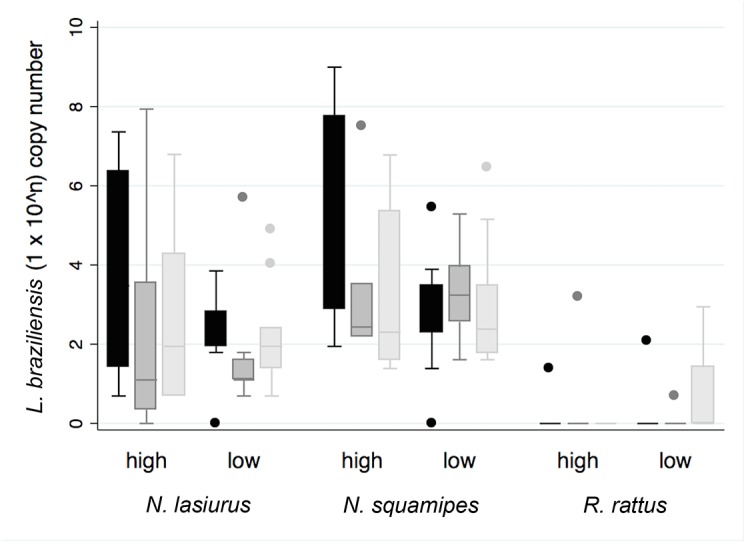

L. braziliensis log10+1 cell counts estimated by qPCR in tissue samples collected from rodent species that received initial high or low inoculum dose (x-axis).Colour shades represent tissues: skin (black), spleen (dark grey), and liver (light grey). Cell counts were standardised to the number of host gene GAPDH copies.